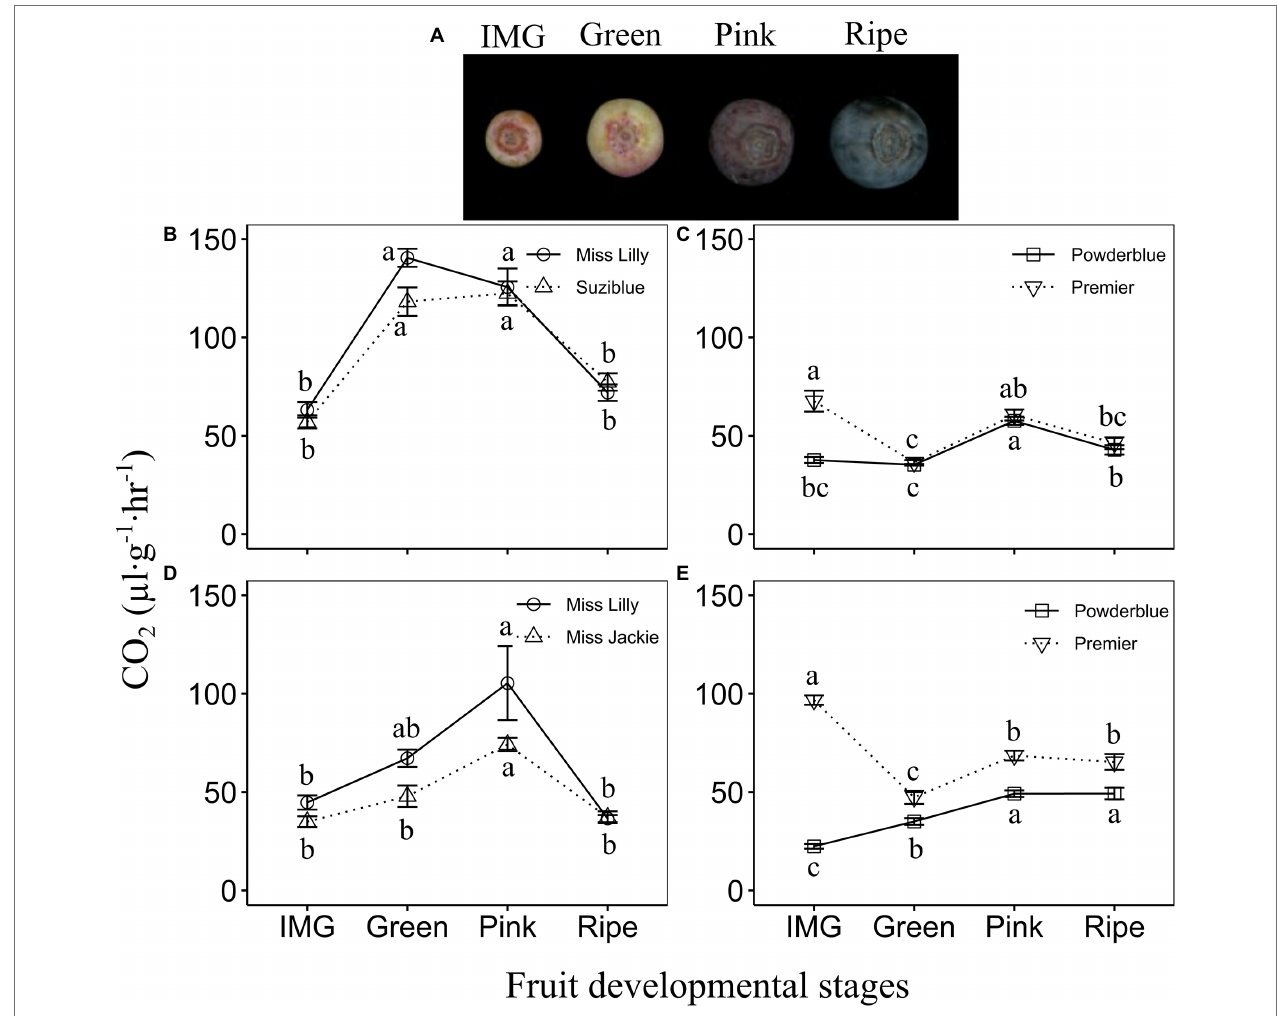
FIGURE 1 | Fruit developmental stages (A) . Respiratory rate in southern highbush (B,D) and rabbiteye (C,E) blueberry cultivars during fruit ripening in 2017 (B,C) and 2018 (D,E) . IMG: Immature Green. Different letters indicate that the means are significantly different at different fruit stages within a given cultivar based on ANOVA and Tukey’s HSD ( α =